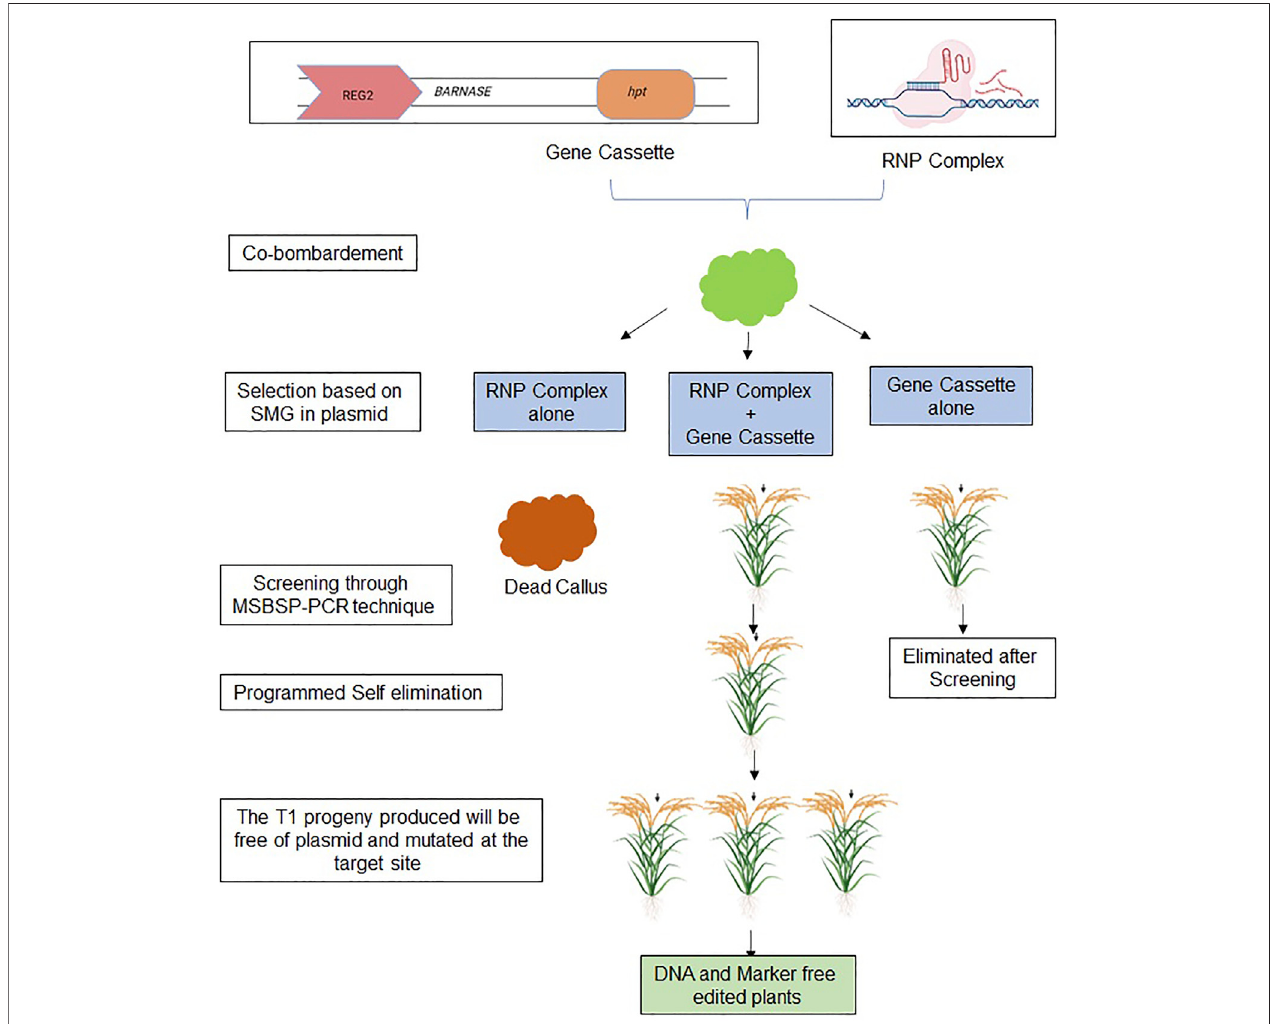
FIGURE 4 | A hypothetical model for the development of DNA and marker-free genome-edited